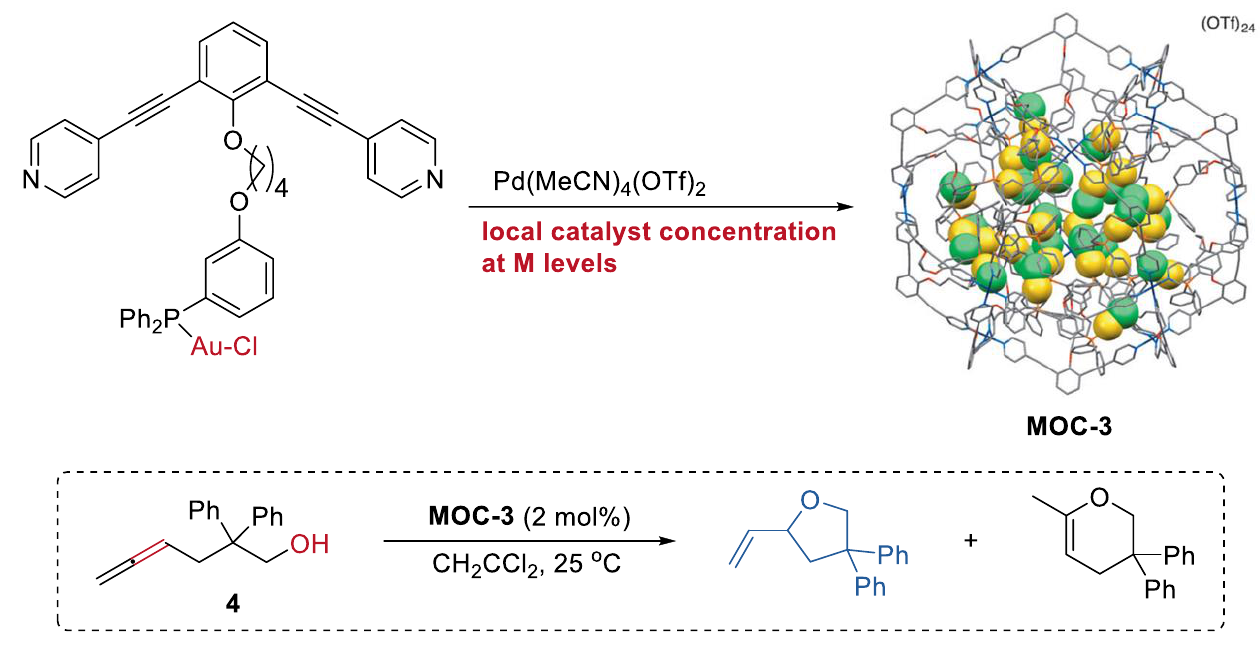
Figure 3. Hydroalkoxylation of the g-allenol catalyzed by MOC-3 with a high local Au catalyst concentration [49] . Reaction additions: 4 (10.4 mM), MOC-3 (2 mol%), CH 2 CCl 2 , 25 °C. Reprinted/adapted with permission from Ref. [49]. Copyright 2014 Wiley VCH.